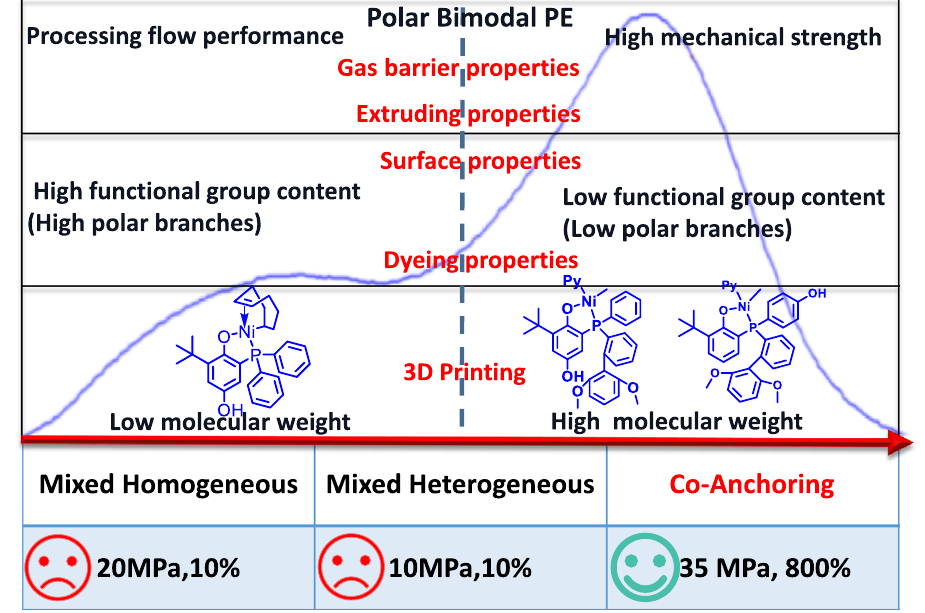
Fig. 1 | Expected properties of polar bimodal polyethylene by combining low- molecular-weight and high-molecular-weight fractions. Below are listed the